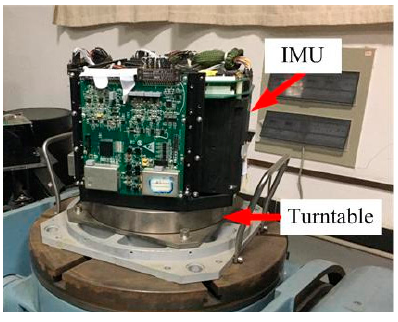
Figure 5. The experimental platform.